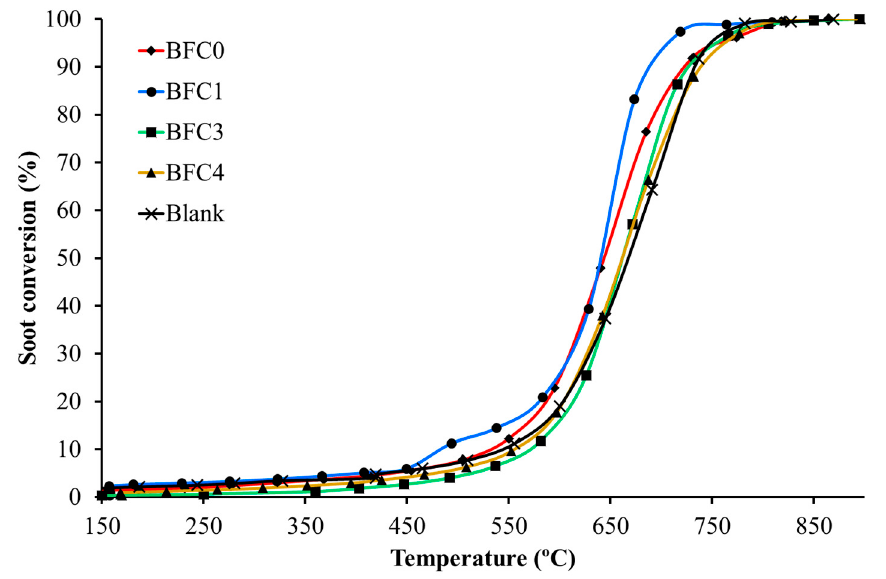
Figure 13. TPR soot conversion profiles in 1% O 2 for BaFe 1 − x Cu x O 3 catalysts.